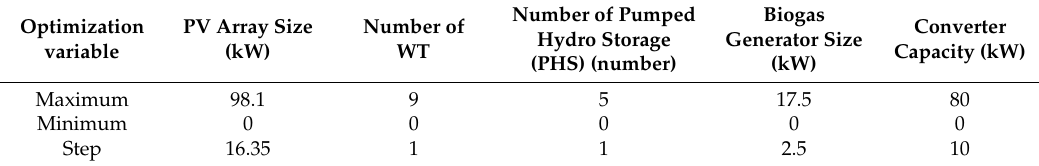
Table 8. Optimization variables of the study